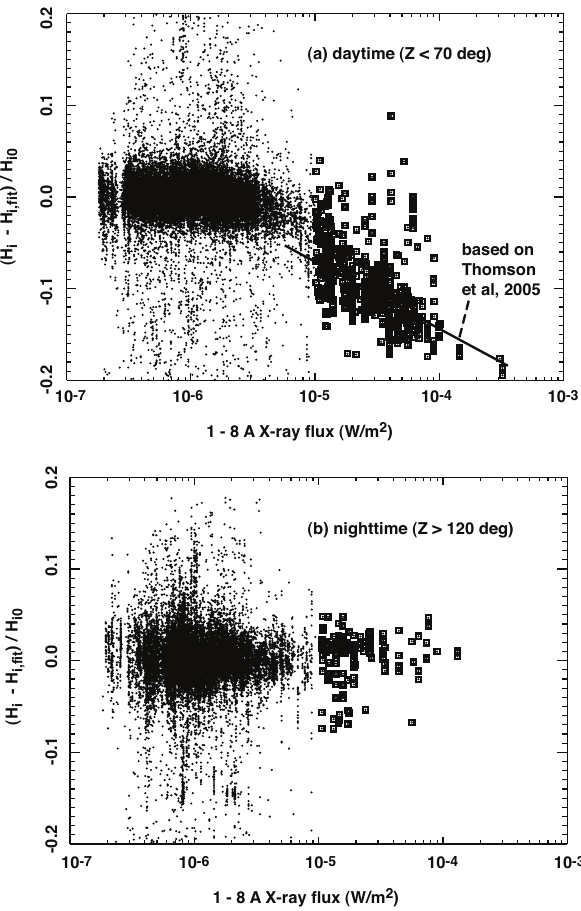
Fig. 8. Scatter plot of zenith-, range-, and azimuth-corrected dimen- sionless height versus long-wave X-ray flux density, for (a) daytime, and (b) nighttime. The heavy solid squares surround data at X-ray fluxes greater than M-flare lower